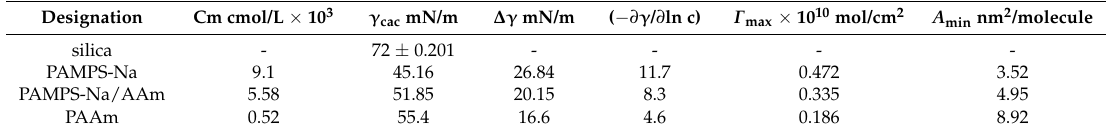
Table 3. Surface activity parameters of silica-nanogel composites in water at 25 ◦